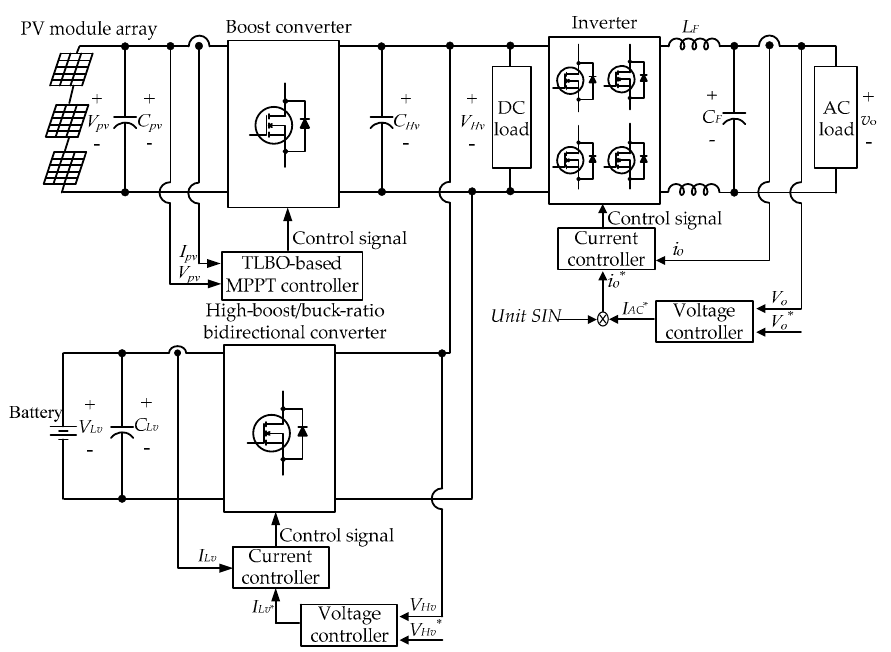
Figure 1. System architecture of the proposed photovoltaic system.